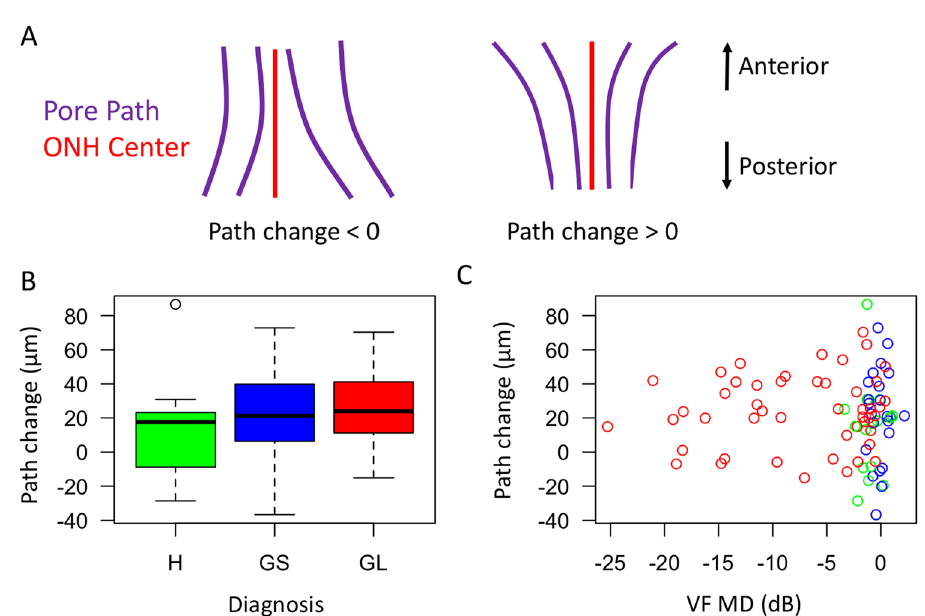
Figure 3. Assessment of pore path relative to disc. ( A ) Schematic demonstration of examples of negative path change (pores move away from disc center going from anterior to posterior) and positive path change (pores move towards the disc center). ( B ) Boxplot of pore path change with respect to diagnosis (H – healthy, GS – glaucoma suspect, GL – glaucomatous eyes) and ( C ) visual field mean